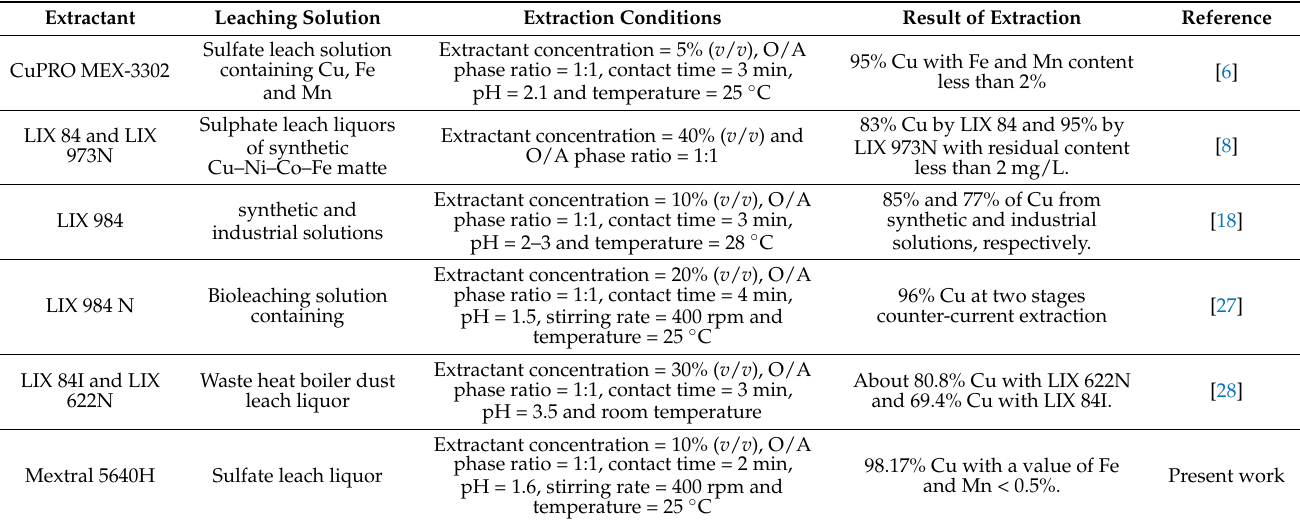
Table 4. The present work in comparison with some previous